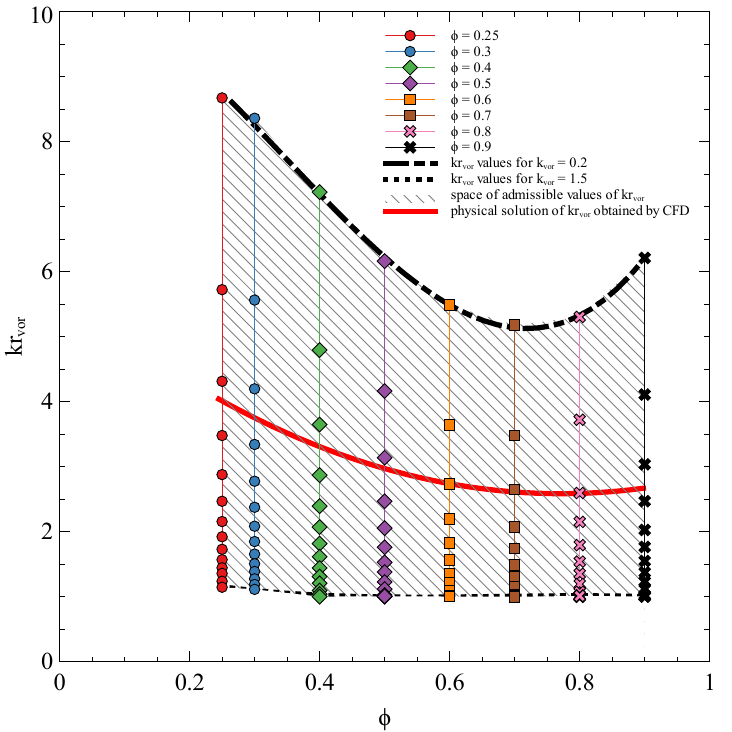
Figure 26. Physical solution of krvor obtained by CFD placed into the overall space of